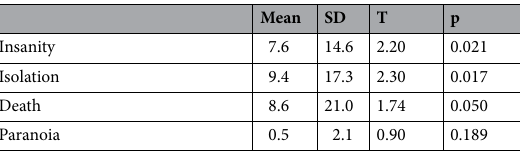
Table 2. Group level summary statistics for acute effects. N = 22; To allow comparison with previous datasets mean ± SD for all group level scores of the applied questionnaires are provided. For the 5D-ASC, the ASC in its 11 factor analysis, MEQ, CEQ scores, we performed one sample t-tests (df = 21) against zero and provide p-values. Please note that data is reported in its completeness and raw significance values are reported instead of significance thresholding. The scores of the ASC, MEQ and CEQ are designed to assess differences from zero, while the PCI items are anchored with two opposing statements (See “Methods”) to the end of the scale [0: minimum; 6: maximum], therefore not being tested against zero.